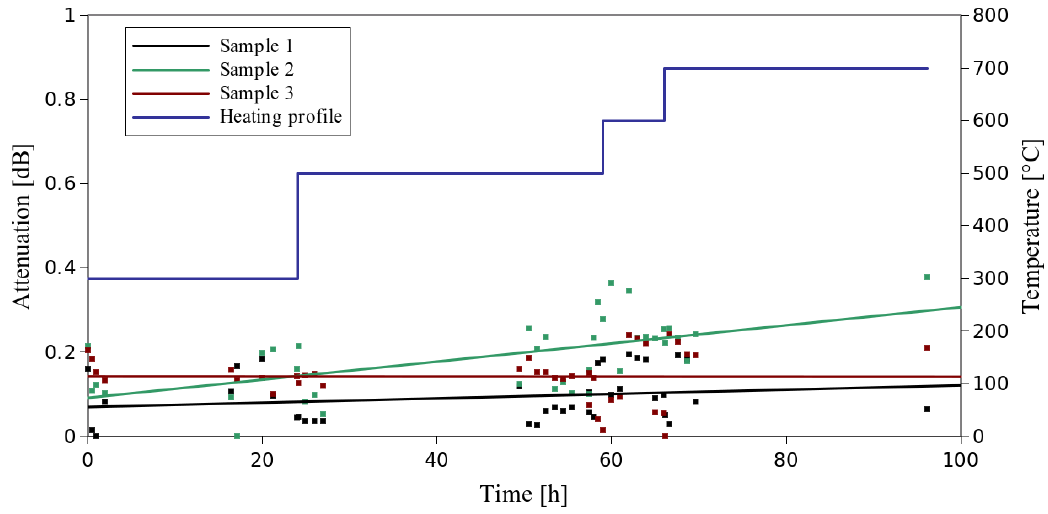
Figure 2. Heating profile and attenuation change over the time of measurement of copper-coated fibers.